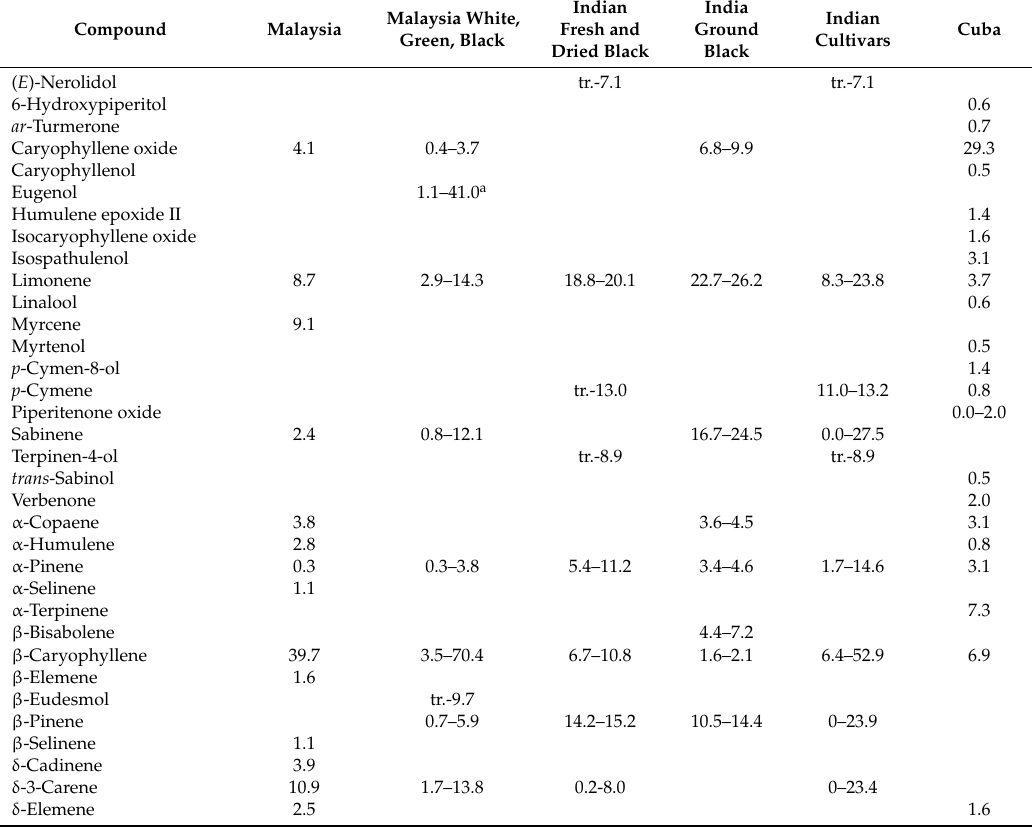
Table 11. Chemical compositions (%) of Piper nigrum L. fruit essential oils